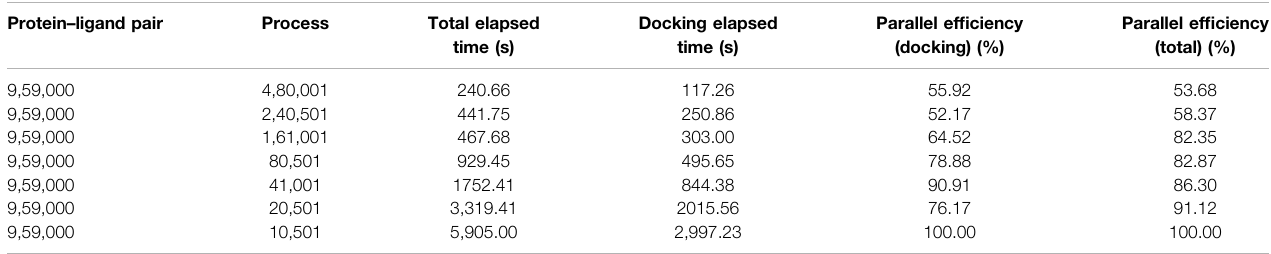
TABLE 1 | Parallel ef fi ciency of the total elapsed time and docking elapsed time. Protein – ligand pair